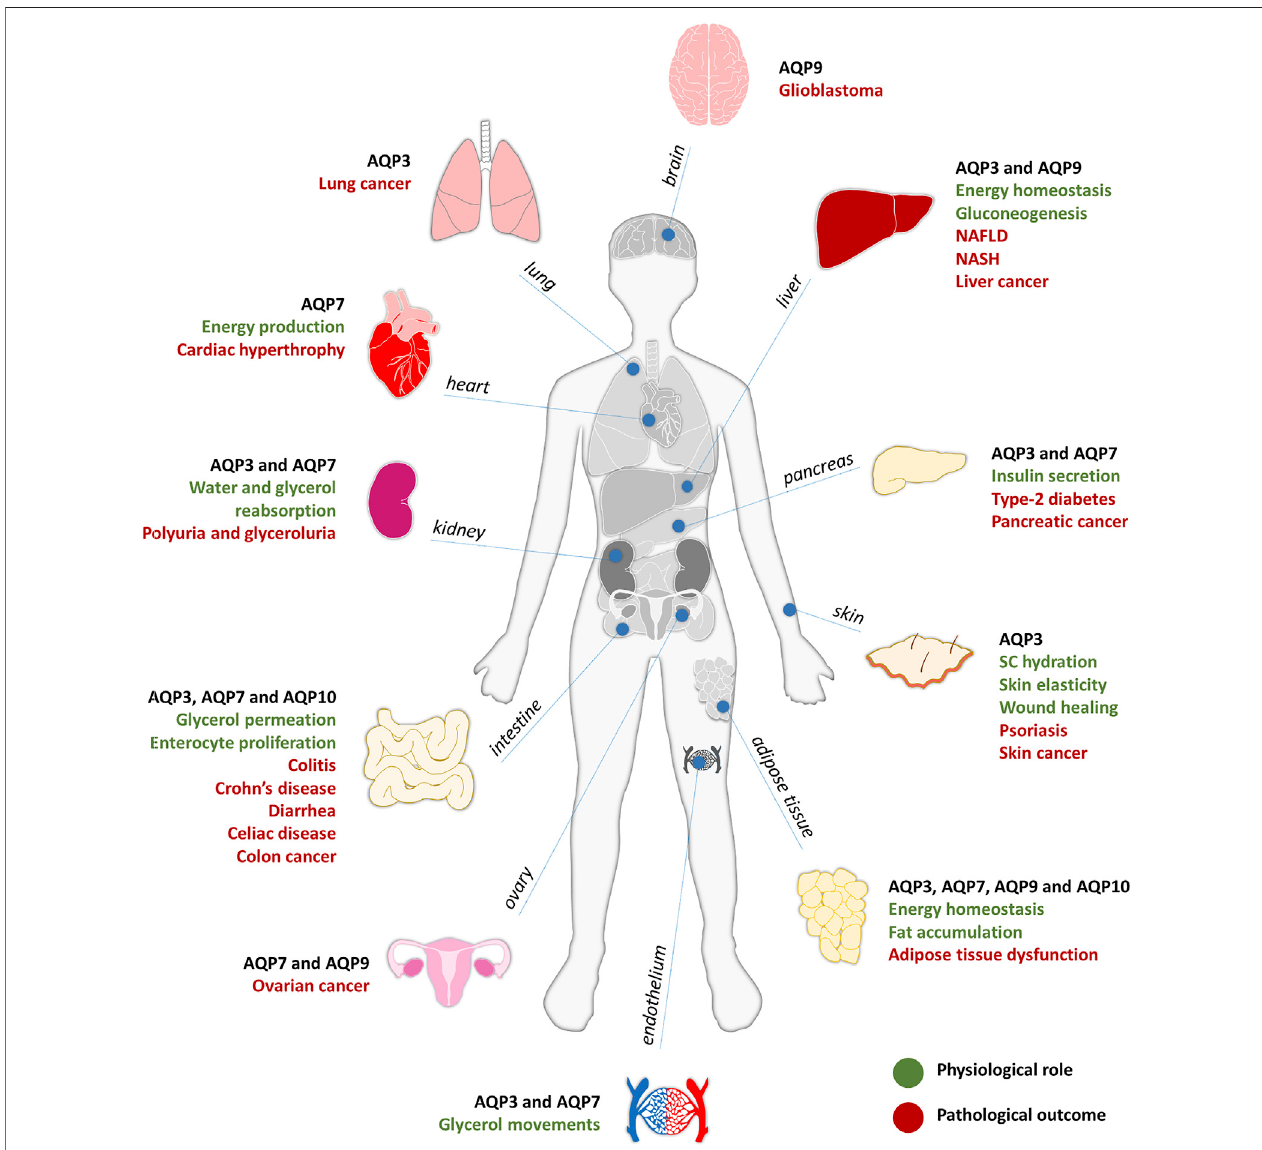
FIGURE 1 | Aquaglyceroporins involvement in physiology (in green) and pathology (in red), described for each organ of the human body.